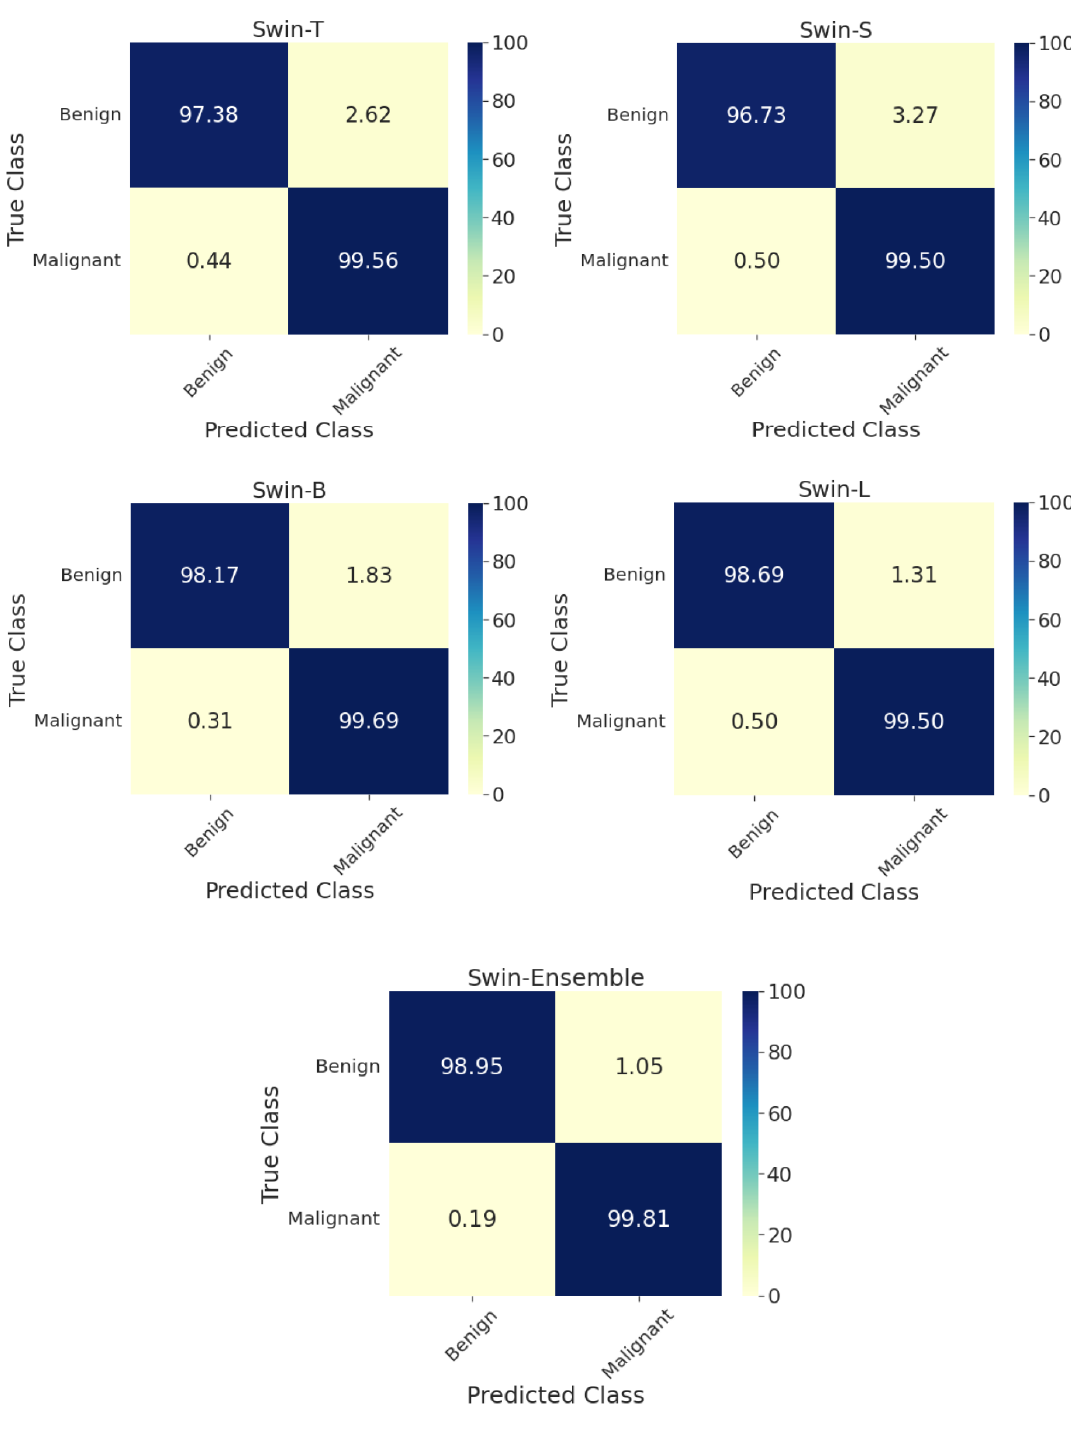
Figure 3. Confusion matrices on the test set for the two-class classification of benign and malignant types for individual swin transformer model as well as the average ensemble model by considering images from all zoom factors. T: tiny, S: small, B: base, L: